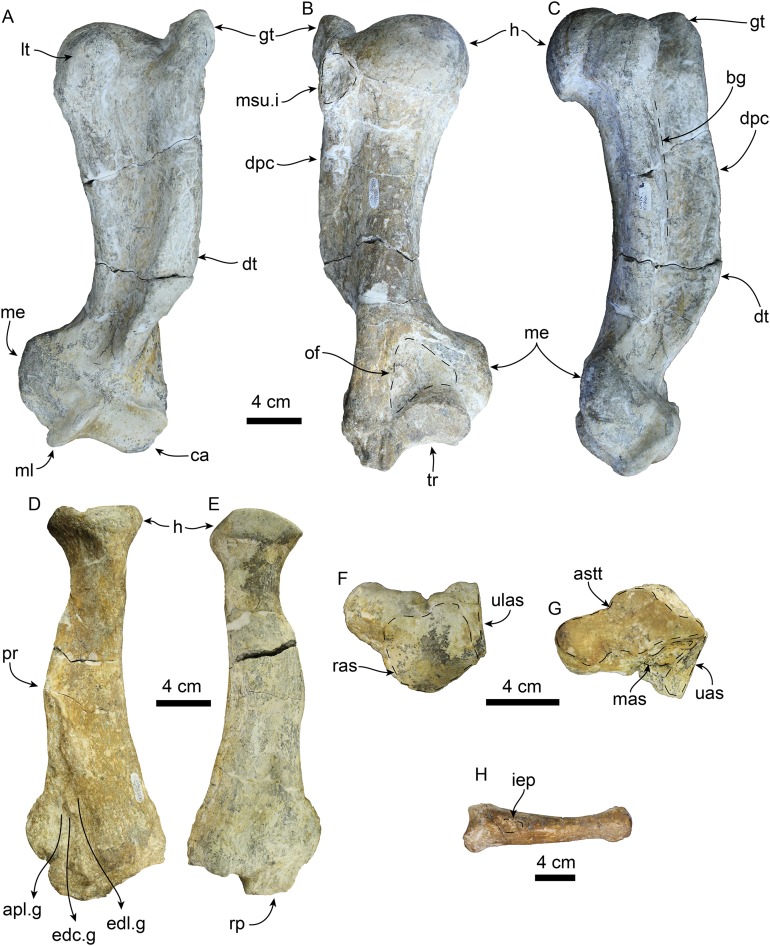
Forelimb elements of Titanotaria orangensis n. gen. et sp. (OCPC 11141).Left humerus in anterior (A), posterior (B), and medial (C) views; left radius in lateral (D), and medial (E), views; left scapholunar in proximal (F), and dorsodistal (G), views; left metacarpal I in dorsal (H) view. Abbreviations: apl.g, groove for tendon of M. abductor policis; astt, articular surface for trapezium and trapezoid; bg, bicipital groove; ca, capitulum; dpc, deltopectoral crest; dt, deltoid tubercle; edc.g, groove for tendon of M. extensor digitorum communis; edl.g, groove for tendon of M. extensor digitorum lateralis; gt, greater tubercle; h, head; iep, insertion for M. extensor pollicis; lt, lesser tubercle; mas, magnum articular surface; me, medial epicodyle; ml, medial lip of trochlea; msu.i, insertion of M. supraspinatus; of, olecranon fossa; pr, pronator ridge; ras, radial articular surface; rp, radial process; tr, trochlea; uas, unciform articular surface; ulas, ulnar articular surface.